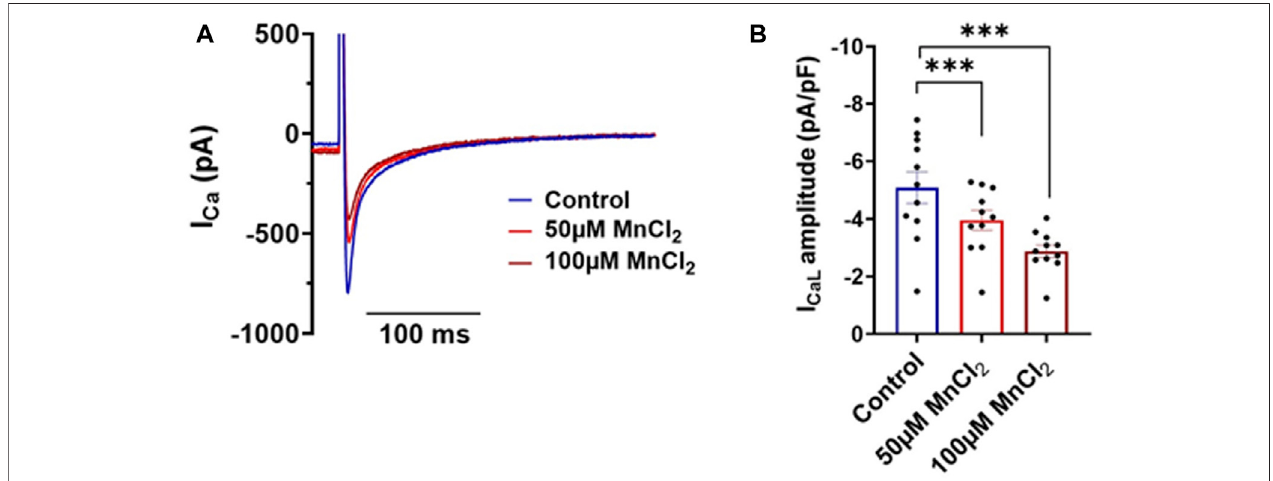
FIGURE4| EffectsofMnCl 2 oncalciumcurrentsofratventricularcardiomyocytes (A) Representativeplotsofcalciumcurrentsincontrolcondition(blueline)andat 50 µM(light redline)and at100 µM (dark red line)ofMnCl 2 (the capacitance ofthecell is107pF) (B) Calciumcurrentdensity independing ondifferentconditions. N =3, n = 11. *** p <